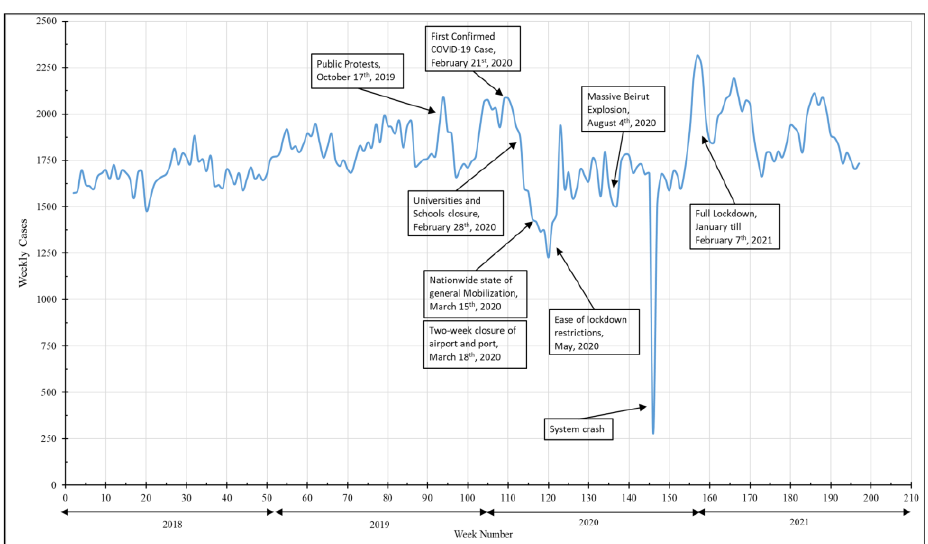
Fig. 1. Weekly Missions 2018-2021